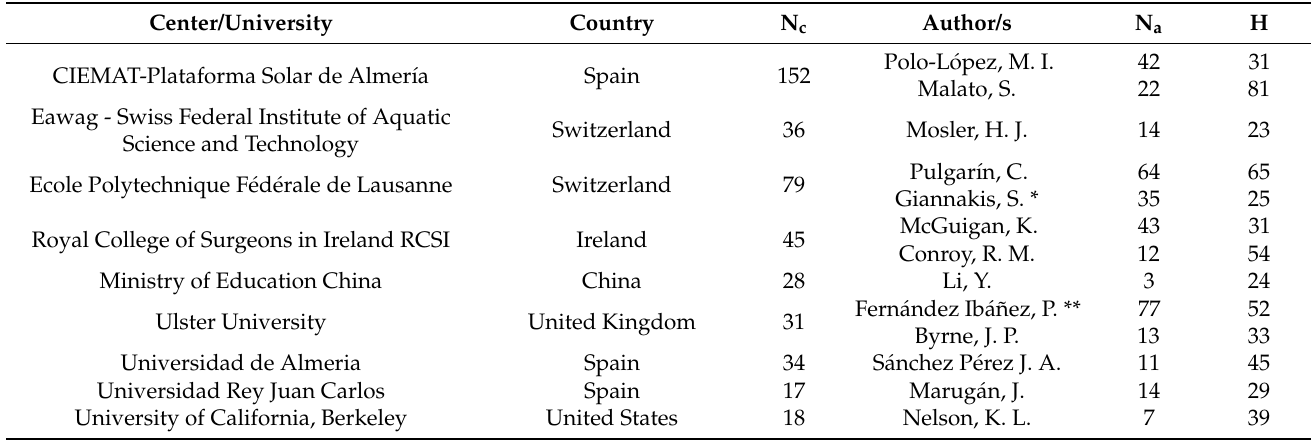
Figure 2. Distribution of publications on solar-driven disinfection in countries with more than 10 publications (Powered by Bing © GeoNames, Microsoft, Navinfo, TomTom, Wikipedia). Table 2. Affiliation (sorted alphabetically) and authors with publications on solar-driven disinfection. In the case of authors, only the most prolific and affiliated to centers that have published more than 10 documents are listed. N c : Documents by institution (not per country), and N a : Documents by author (only one or two of the most prolific authors are listed per center). H: